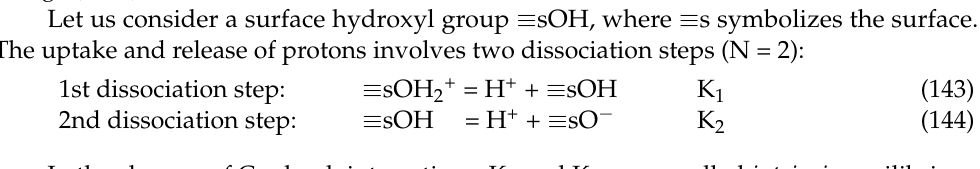
Table 14. Intrinsic pK values and pH pzc for surface complexation on four (clay) minerals [40].